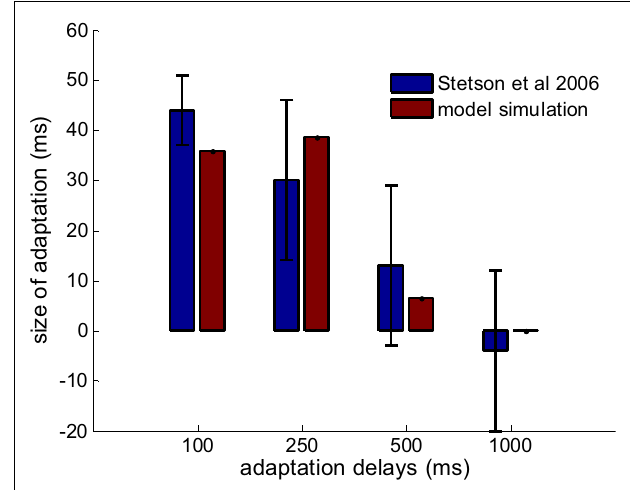
FIGURE 4 | Prediction of the model on the limited adaptation size for large adaptation delay (red bars). Results from Stetson et al., 2006 are reproduced in blue bars with permission ( n =25, 5, 4, 4 for the adapting delays of 100, 250, 500, and 1000ms).The delay-tuned neurons have a limit on the offsets that they can encode, which gives rise to this limited capacity of